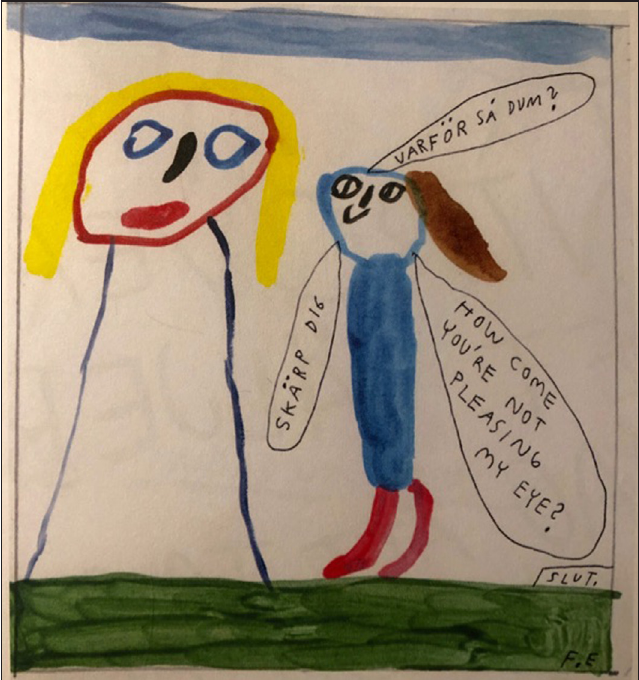
Figure 3: Freja Erixån (2019) Över min döda kropp. Stockholm: Kartago. © Freja